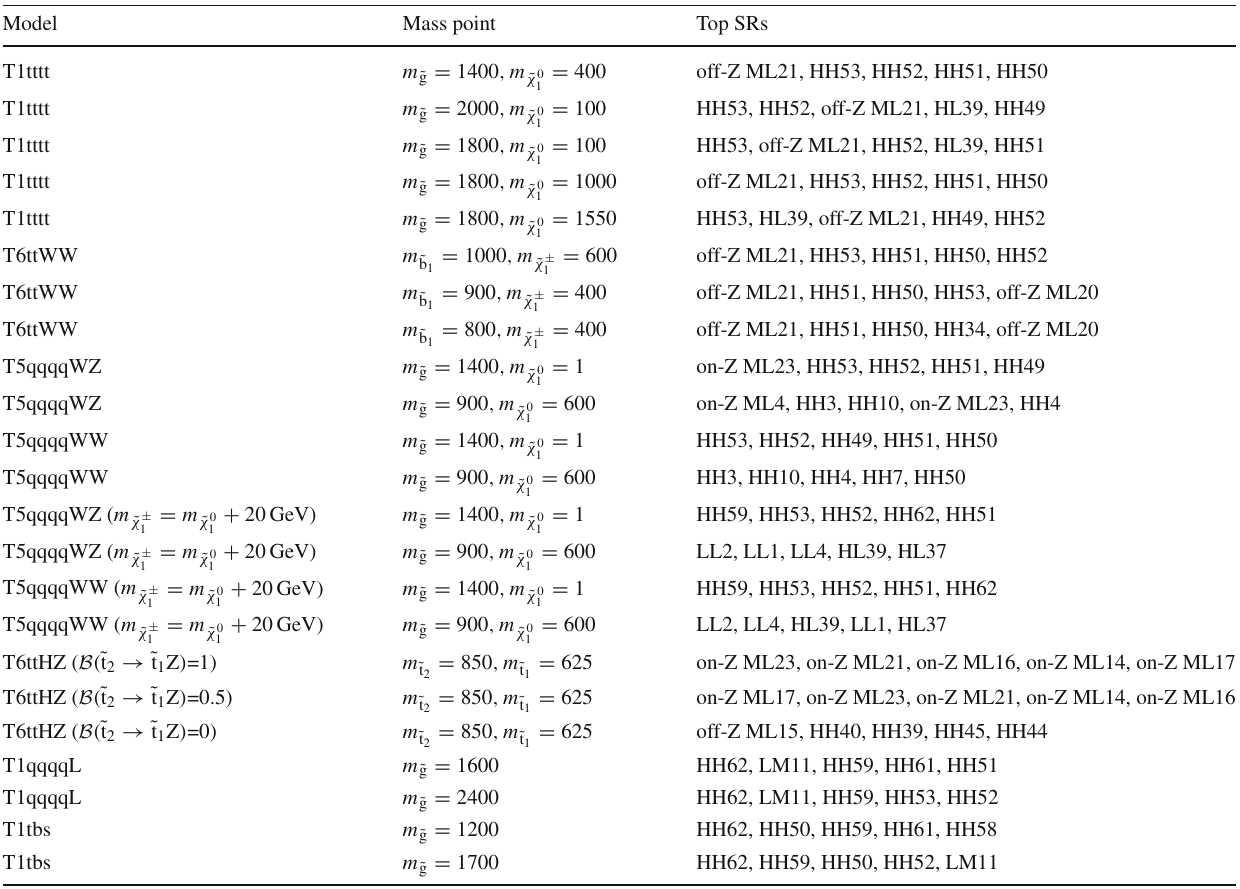
Table 17 Top five SRs for several representative models, ranked based on the largest values of N sig. / signal and total background yields in each SR,